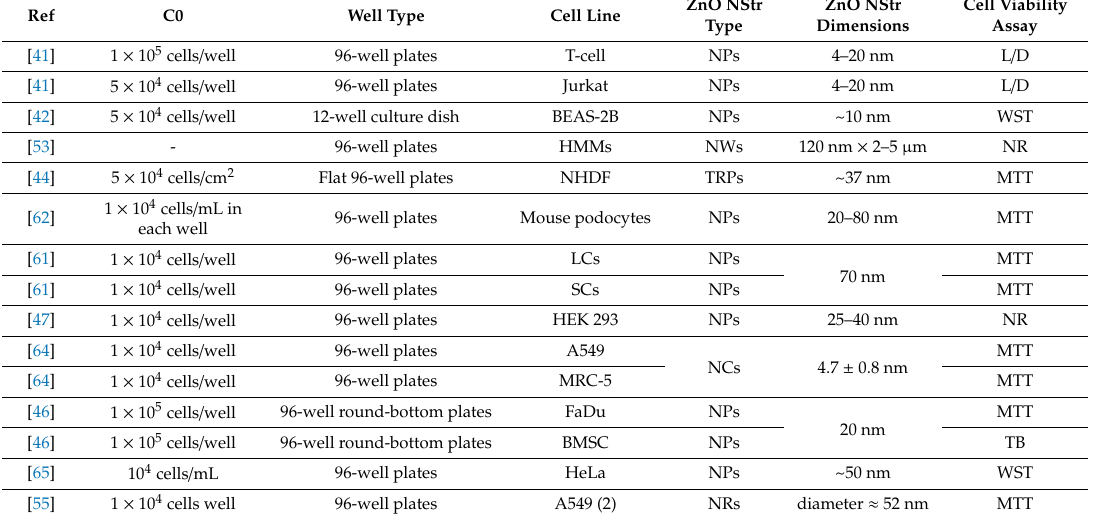
Table 1. Description of the systems analyzed in the graphic reconstruction of Figure 5. MTT, 3-(4,5 -dimethylthiazol-2-yl)-2,5-diphenyltetrazolium bromide assay; L / D, live / dead viability /